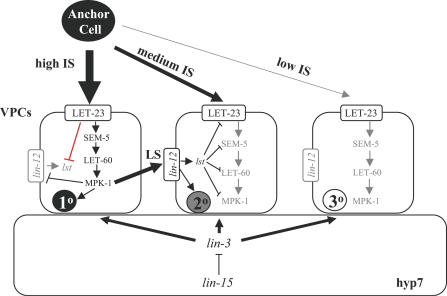
Conceptual Model for the Signaling Events Underlying VPC Fate SpecificationThe thickness of the inductive signal (IS) arrows indicates the relative levels received by the three VPCs shown. With a low level of IS (the rightmost cell), the EGFR/RAS/MAPK pathway is below the threshold needed for induction (indicated in grey), and the VPC adopts the 3° fate. A high level of IS (the leftmost cell) activates the EGFR/RAS/MAPK pathway and induces the 1° fate. High IS also results in the production of a strong lateral signal (LS) by this VPC, the downregulation of LIN-12, and, as predicted by our computational model (see below), in the inhibition of the lst genes as indicated by the red line. The middle VPC receives a medium IS; however, the EGFR/RAS/MAPK pathway is counteracted (indicated in grey) by the lst genes activated by the strong LS from the leftmost VPC. The middle VPC thus adopts the 2° fate.